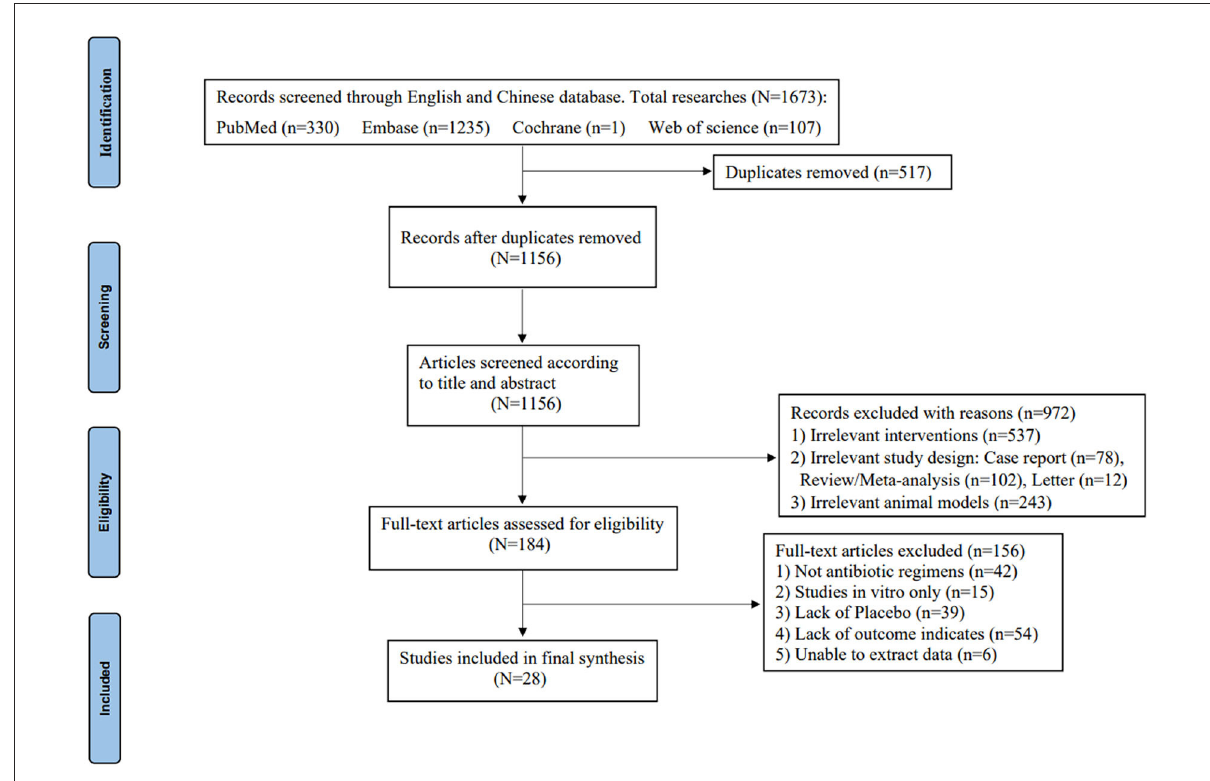
FIGURE1 PRISMA flow diagram of the study selection process